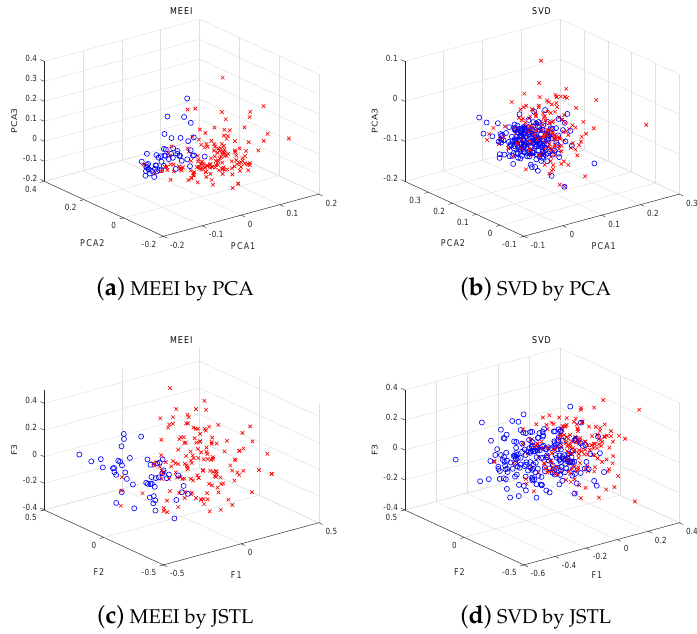
Figure 5. Three dimensional scatter plots of MEEI and SVD extracted by PCA and